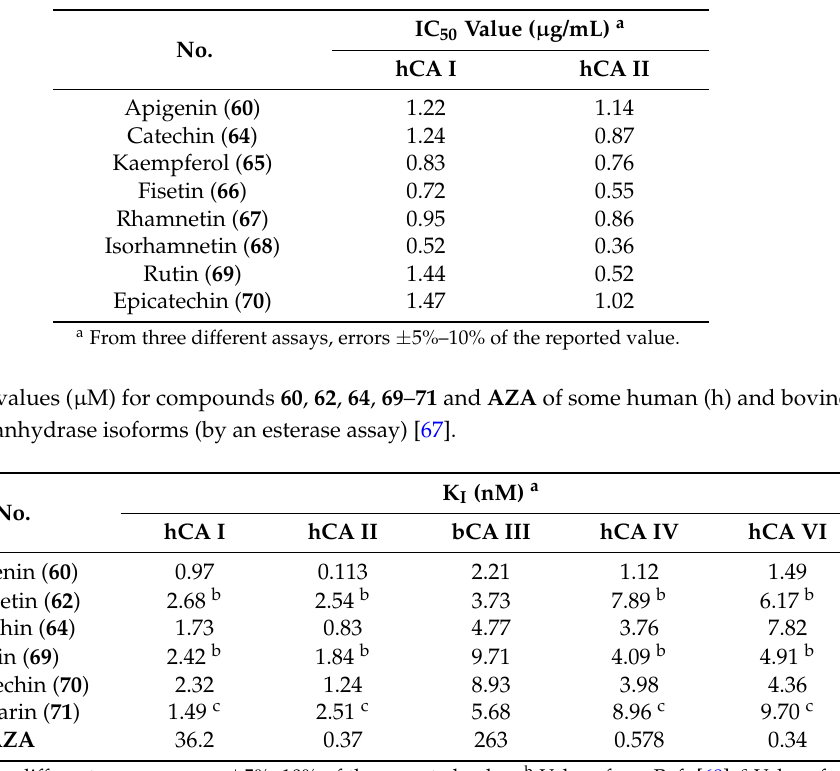
Table 7. hCA isoforms I and II inhibition with compounds 60 , 64 – 70 by a stopped-flow, CO 2 hydration assay [46].